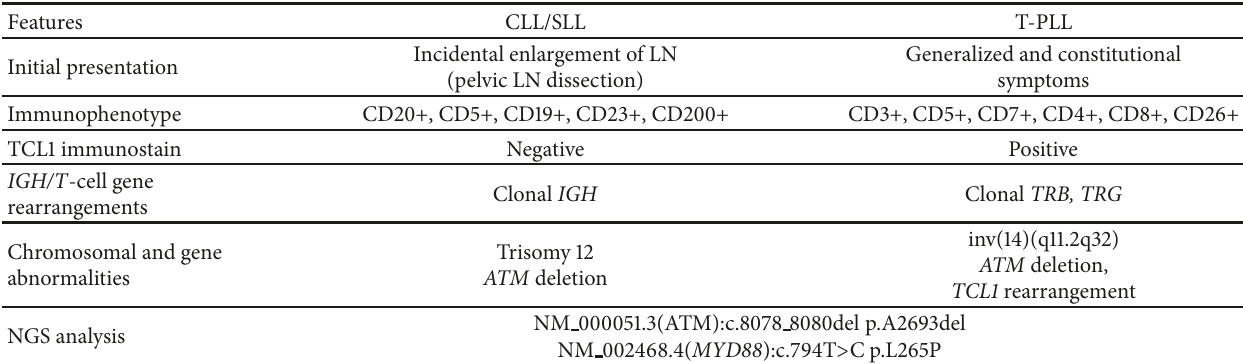
Table 1: Summary of the most important clinical and pathologic features of chronic lymphocytic leukemia/small lymphocytic lymphoma (CLL/SLL) and T-cell prolymphocytic leukemia (T-PLL) as seen in our patient. Of note, these features do not necessarily represent the most common features of CLL/SLL or